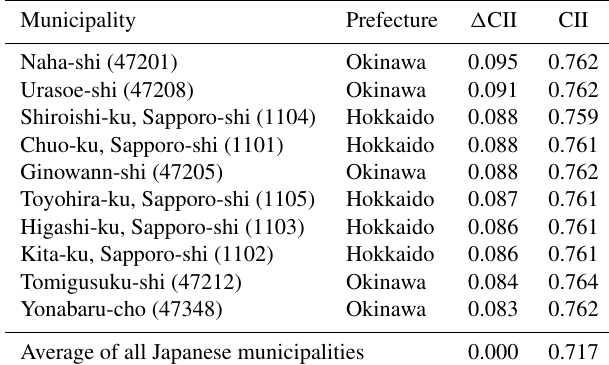
Table 6. A total of 10 municipalities with the highest average (cid:49) CII value over the study period (FY 2014–2016). The municipal number is shown in